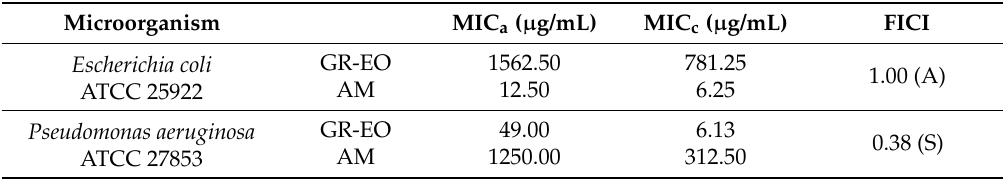
Table 6. Fractional inhibitory concentrations indices (FICIs) of Ampicillin combined with GR-EO against tested bacterial